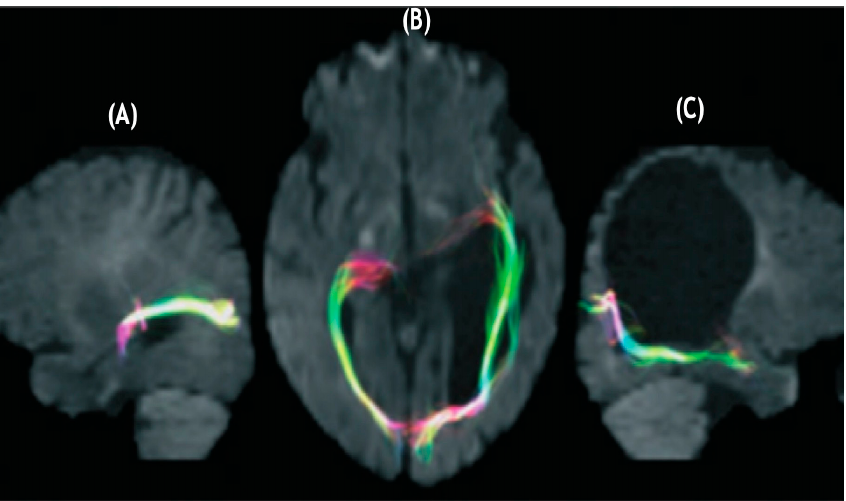
Figure 1. Diffusion tensor tractography of ( A ) optic radiations of left hemisphere evidencing a path- way avoiding an enlarged left ventricle projecting to the calcarine cortex. ( B ) bilateral optic radiations with the fibers of the left hemisphere proceeding laterally and anteriorly in contradistinction to the non ‐ lesioned hemisphere. ( C ) Optic radiations of the right hemisphere appear to follow a normal trajectory (after Guzzetta et al., [56] with permission).